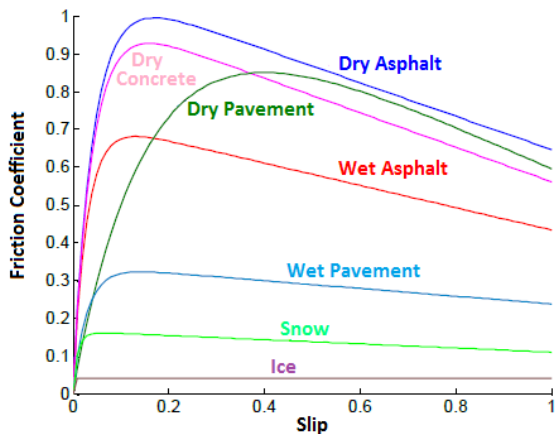
Figure 26. Friction coefficient for different surface types